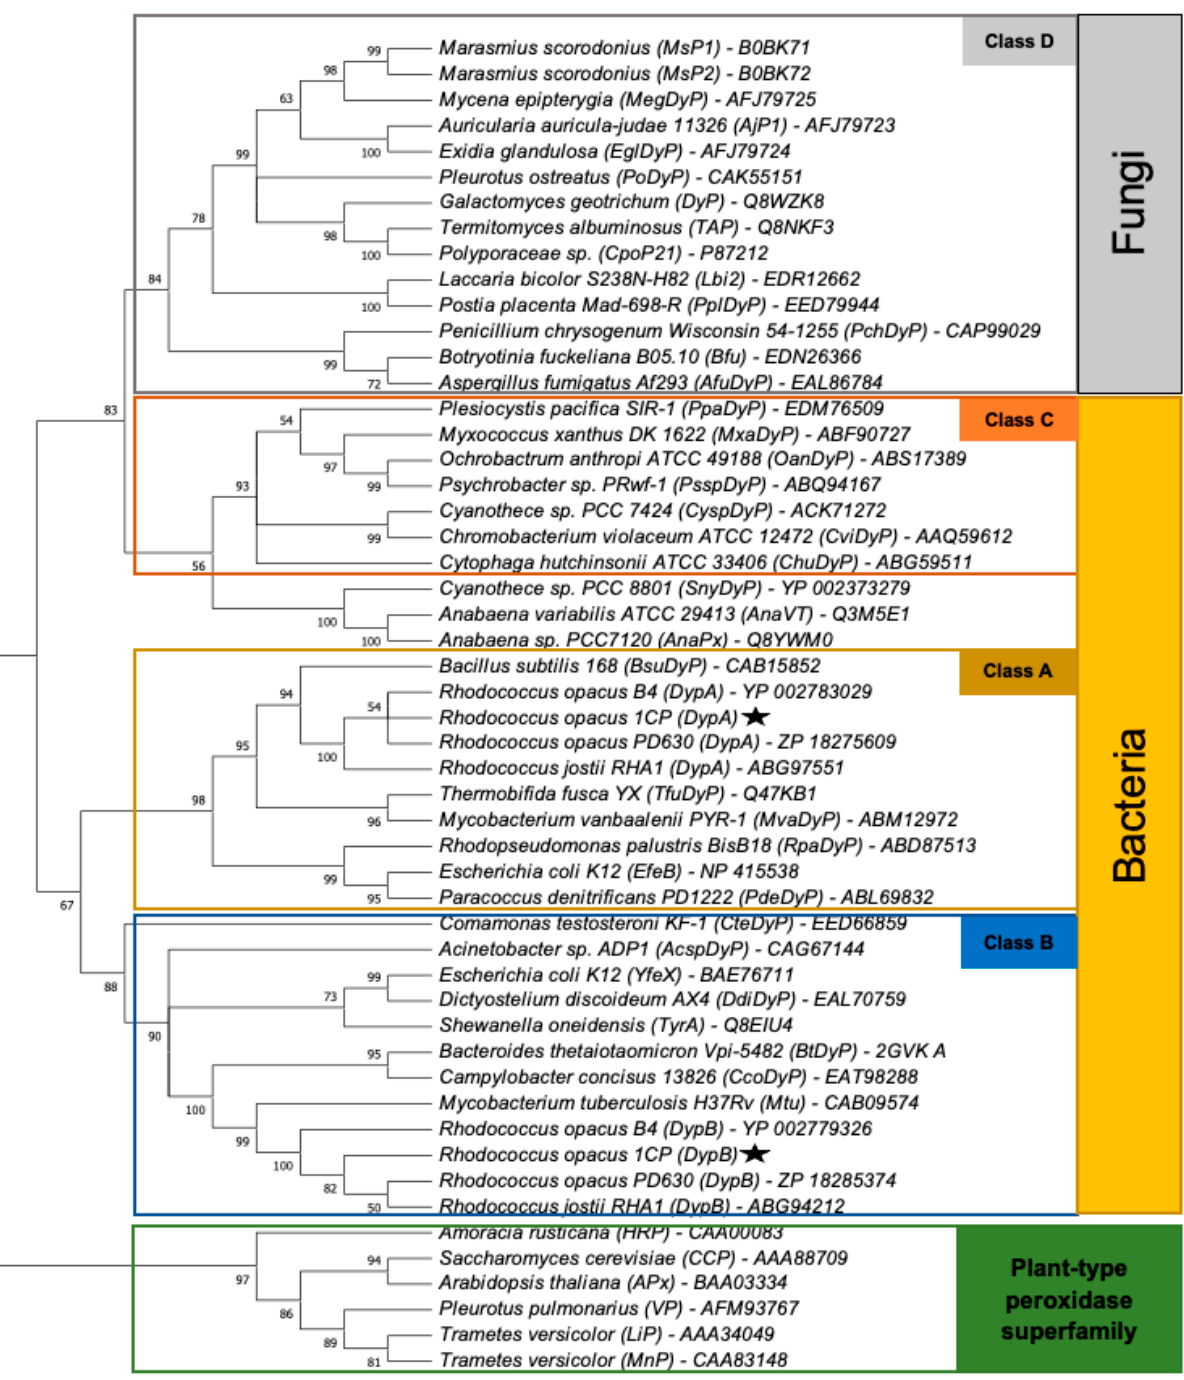
Figure A1. Cladogram of the dye-decolorizing peroxidase superfamily including DypA and DypB from R. opacus 1CP and important representatives of the plant-type peroxidase superfamily. The tree was inferred using the maximum likelihood method and JTT matrix-based model (CITE). Bootstrap values (%) were generated from 1000 replicates. This analysis involved 52 amino acid sequences.